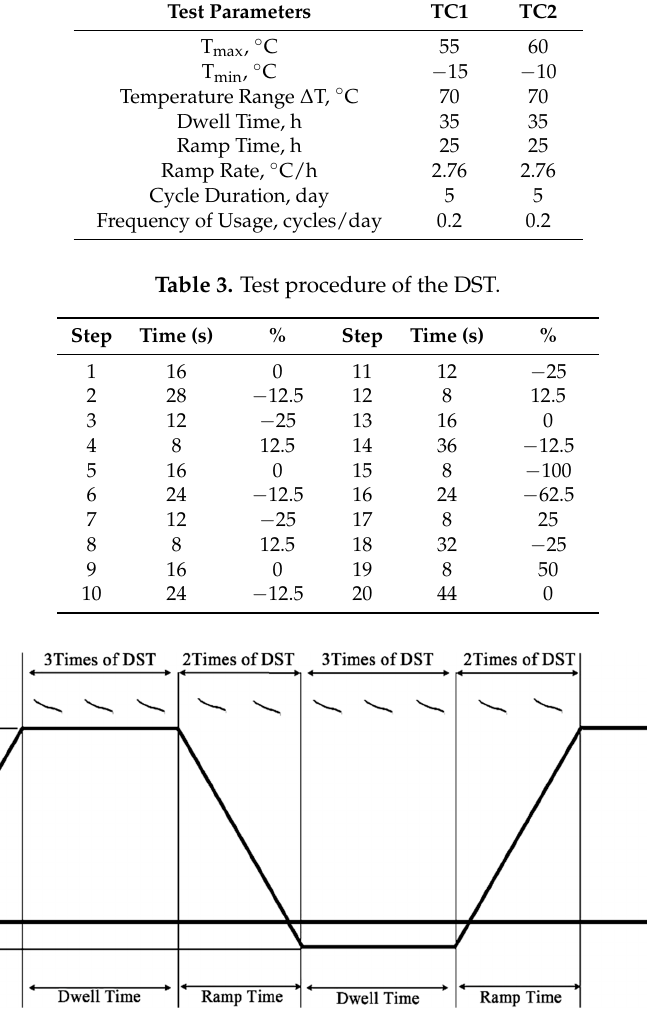
Table 2. Test parameters of the temperature cycling.